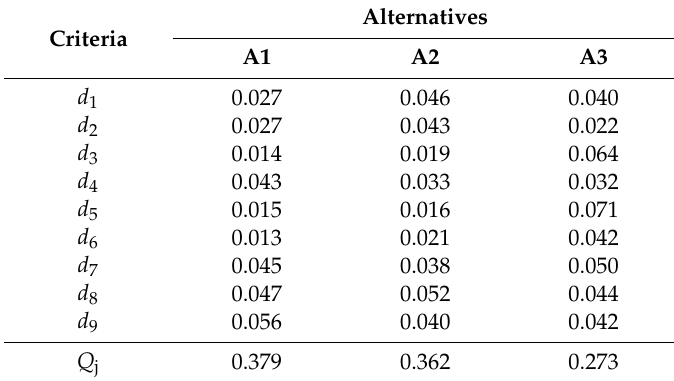
Table 9. Normalized-weighted criteria values d ij and relative importance Q j of each alternative (COPRAS method).